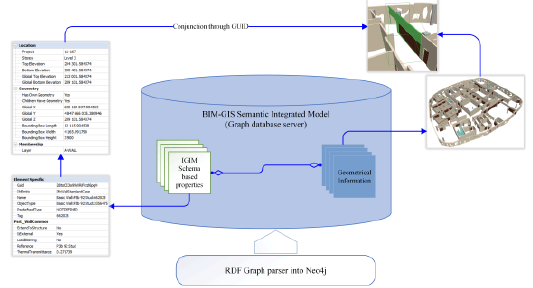
Figure 3: Object linkage between properties and associated